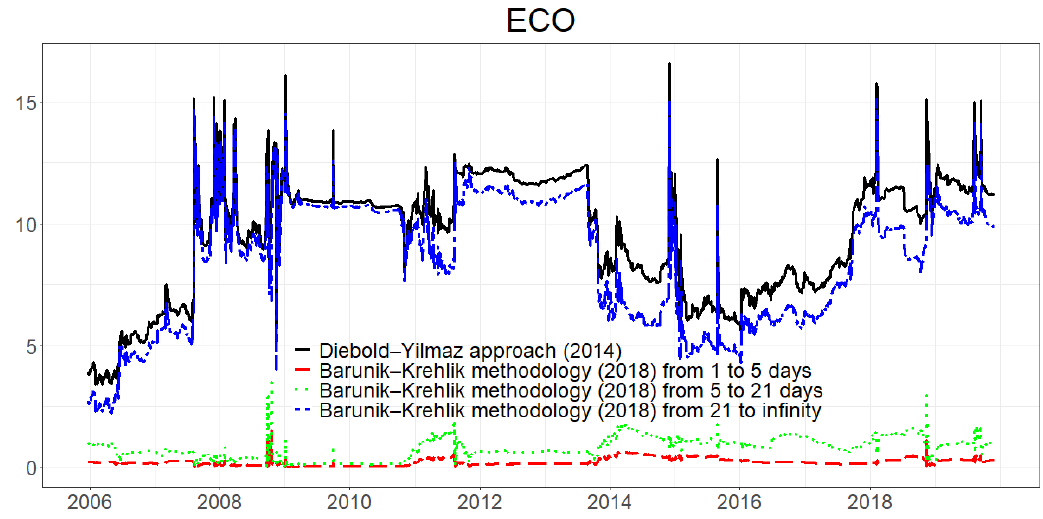
Figure 5. Diebold–Yilmaz [15] directional volatility spillover (from) and Barunik and Krehlik [16] directional volatility spillover (from) in the US. Note: ECO indicates the Wilder Hill Clean Energy Index.